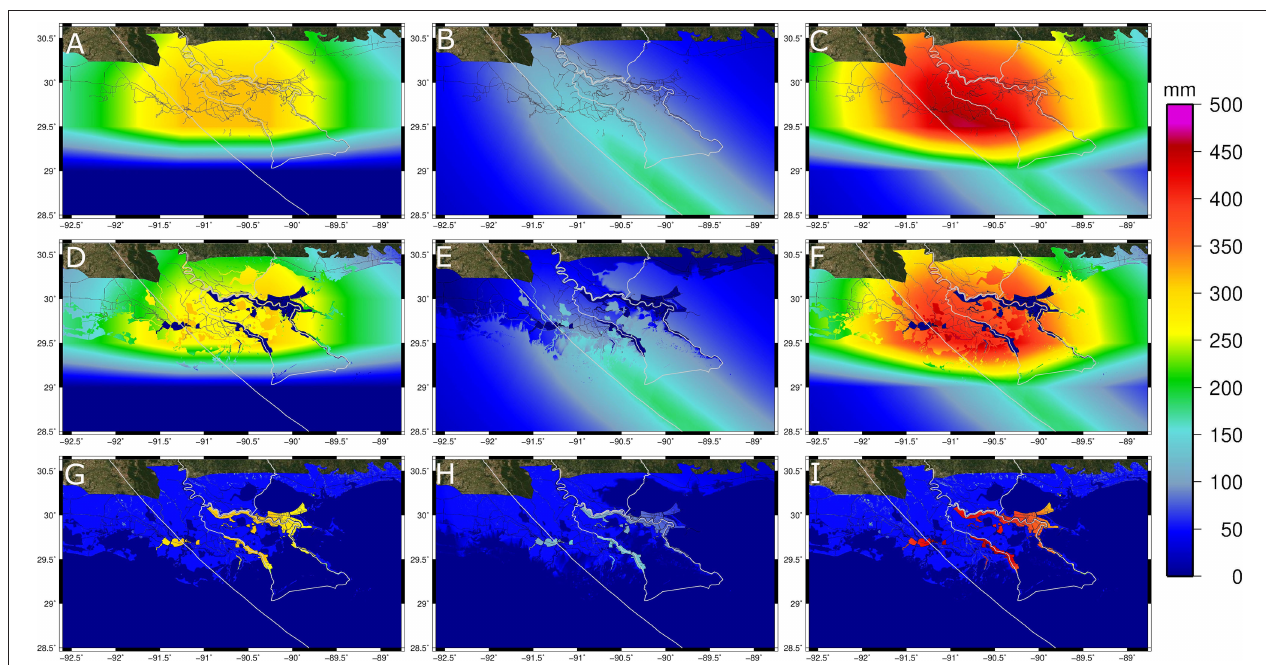
FIGURE 4 | Rainfall totals (mm) based on storm 145 for antecedent conditions (A) , tropical cyclone-driven rain (B) , and combined rainfall (antecedent and TC-driven rain) (C) . The top row (A–C) represents the total rainfall amount, the middle row (D–F) is the portion of rainfall amount applied to the model simulation, and the bottom row (G–I) is the unaccounted portion of the total rainfall. The Barataria and Lake Maurepas watersheds are outlined in gray. The storm track is also shown in